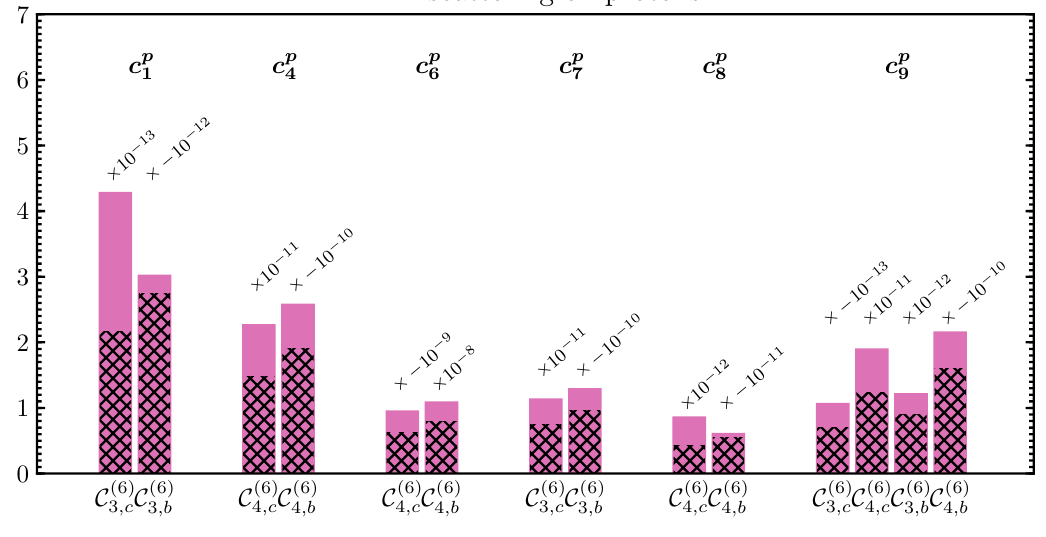
Figure 4 . In magenta: the values of nonrelativistic coe(cid:14)cients c p the scattering of DM on protons, taking only one of the Wilson coe(cid:14)cients nonzero, setting it to ( d ) 2 , with (cid:3) = 1 TeV. Hatched: the results without QCD resummation, eqs. a = 1 = (cid:3) C